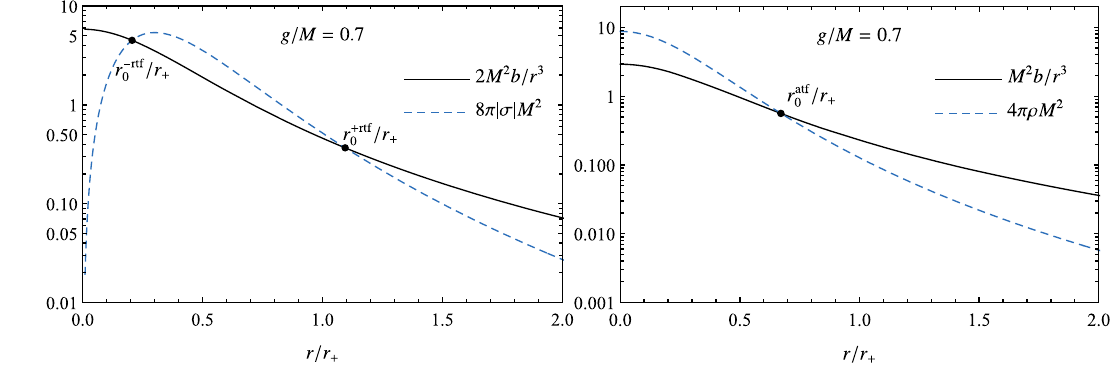
Fig. 2 Contributions from the Misner–Sharp energy b ( r ) (black solid lines) and from the matter (blue dashed lines) to the radial (left) and angular (right) tidal forces for a Bardeen BH with g / M = 0 .